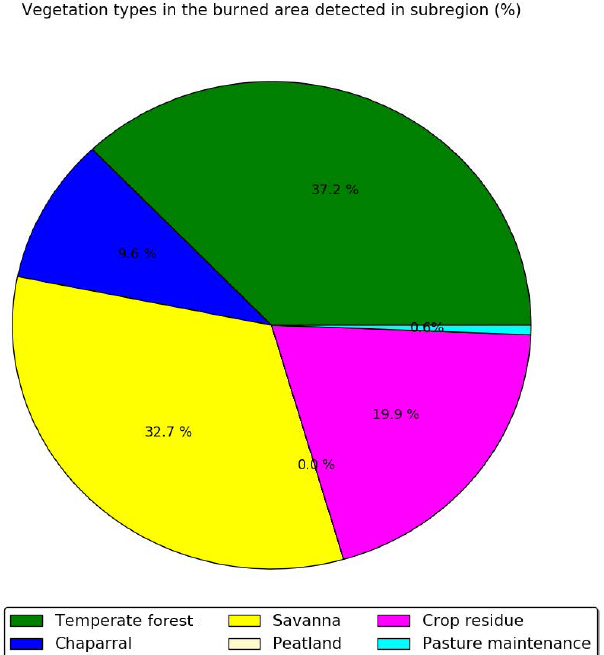
Figure 6. Percentage of the different vegetation types in the burned area detected over the subregion during the summer of